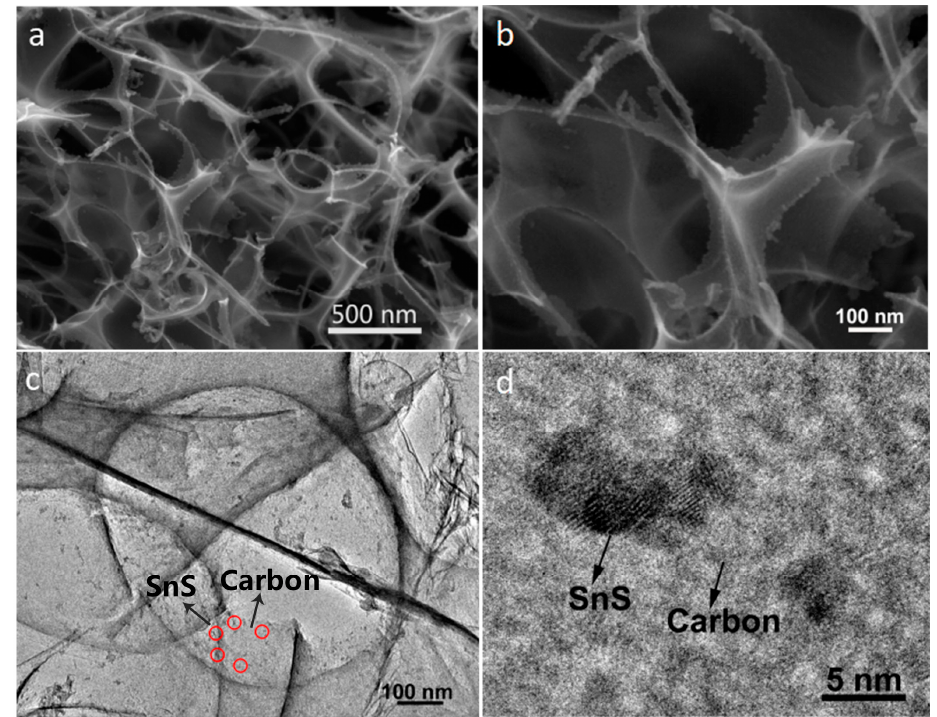
Figure 4. Scanning electron microscope (SEM) ( a , b ) and TEM images ( c , d ) of SnS@C composites.